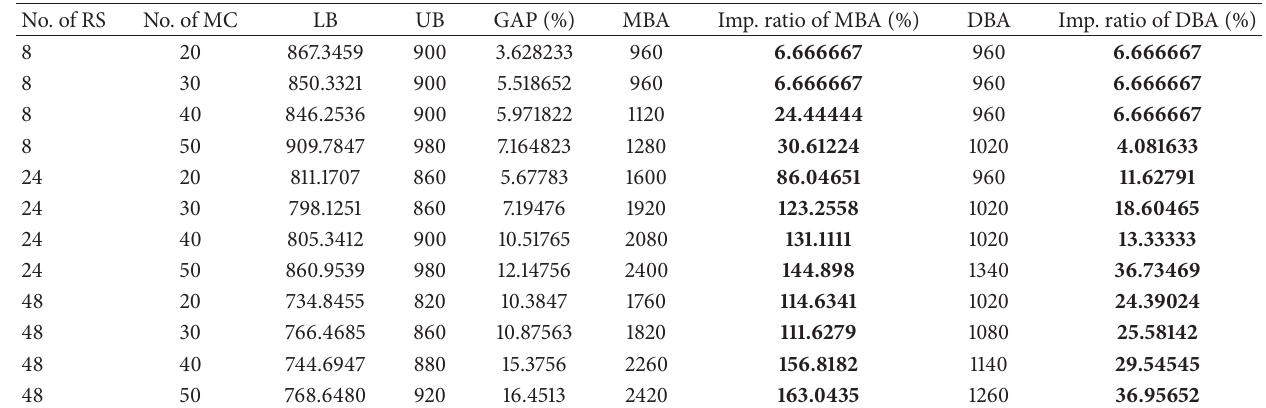
Table 7: Algorithm comparison (1BS, random, 3.2 km).